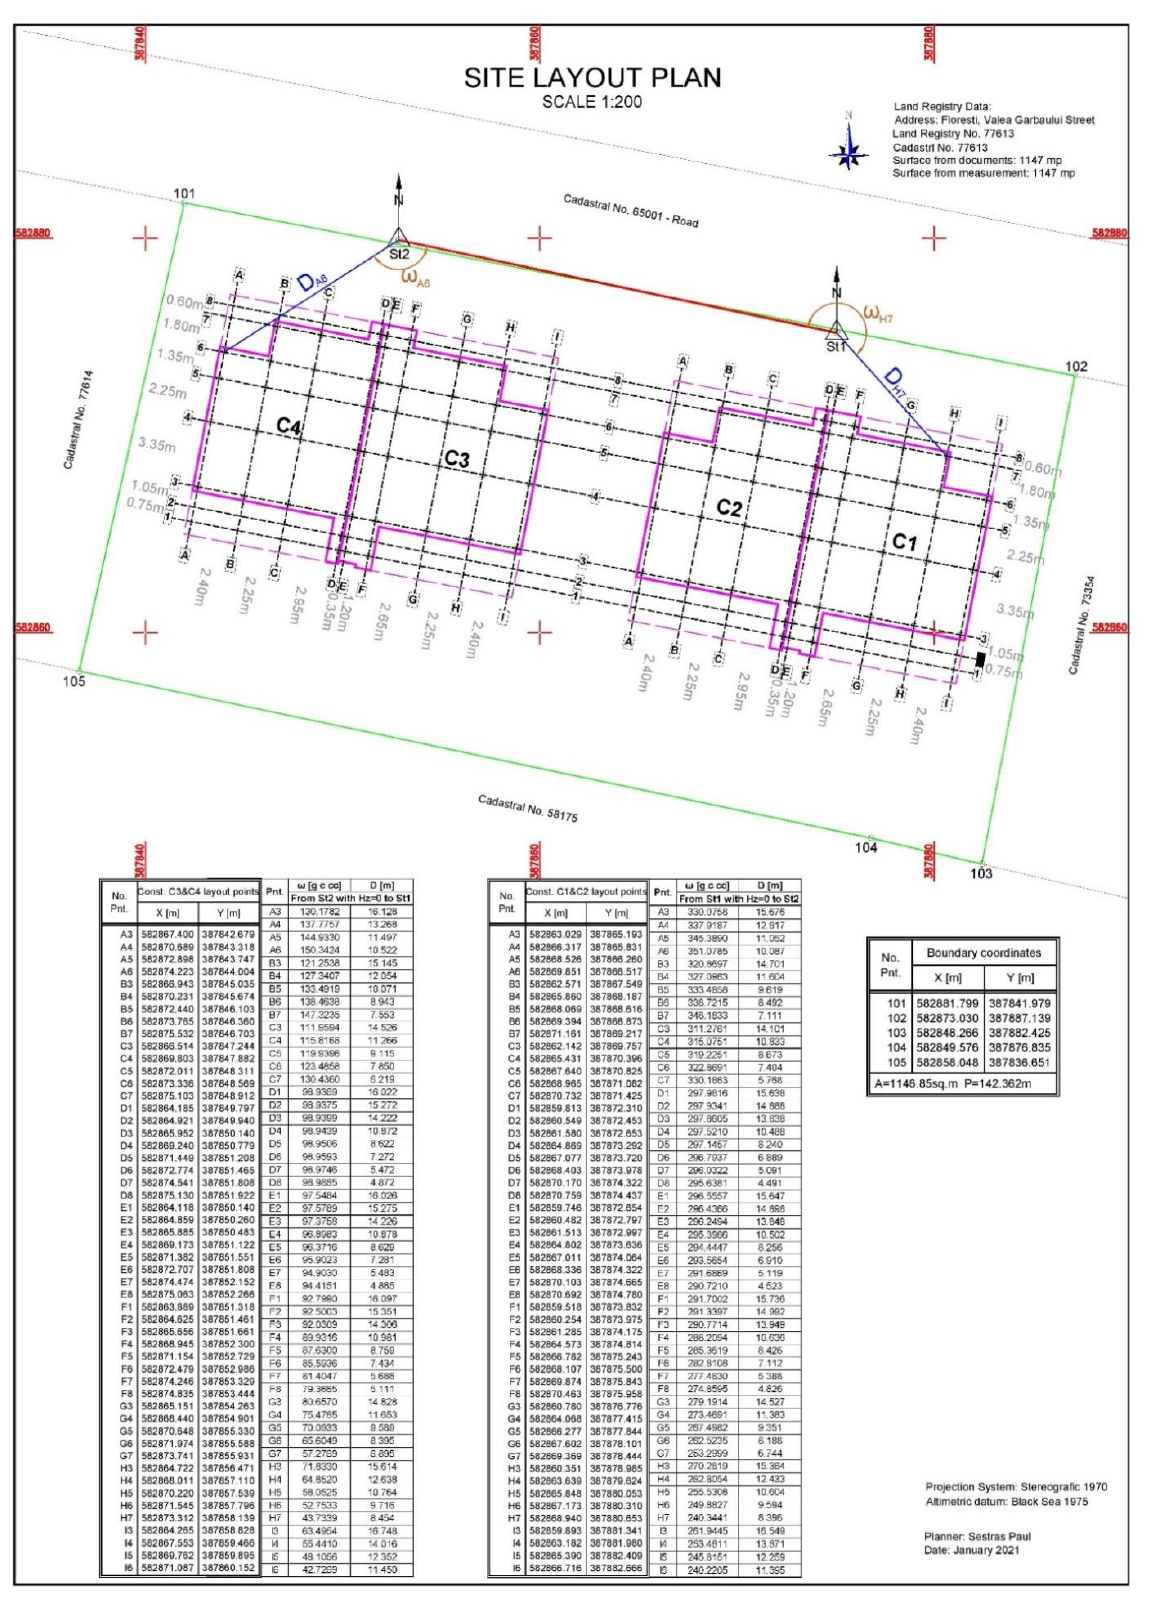
Figure 5. Site layout plan.